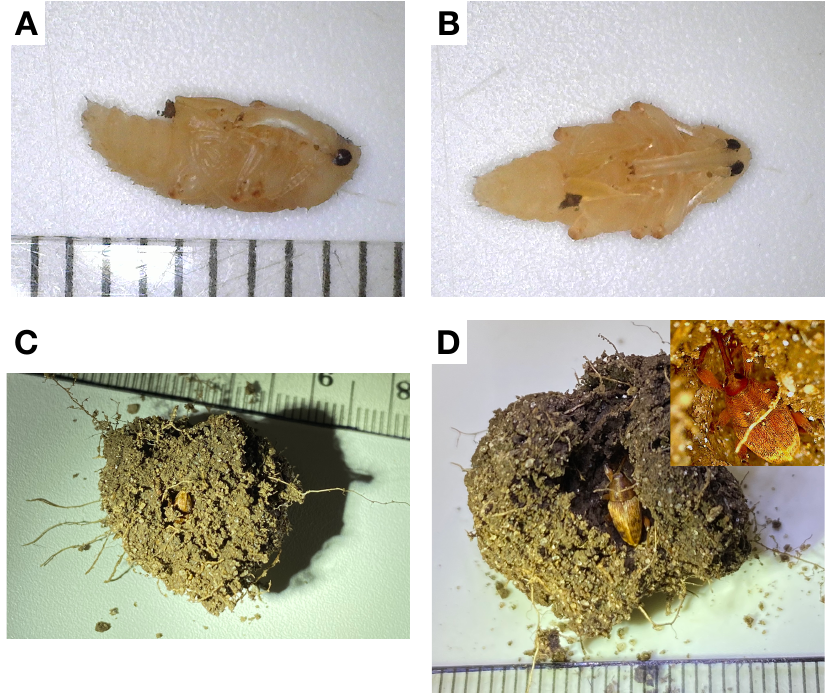
Figure 4. Subterranean life stages of the lesser chestnut weevil ( C. sayi ). ( A ) Side profile of C. sayi pupa. Larvae burrow into the soil to construct pupal chambers in which they pupate. Ruled divisions denote millimeters. ( B ) Ventral view of C. sayi pupa. ( C ) C. sayi adults eclose from pupae but can remain in the soil for a period of time in the pupal chamber. Small-ruled divisions denote millimeters and large-ruled divisions denote centimeters. The adult C. sayi weevil is oriented downward; only the posterior is visible. ( D ) C. sayi adult gently excavated from pupal chamber. Inset provides close up of head and rostrum. Ruled divisions denote millimeters.